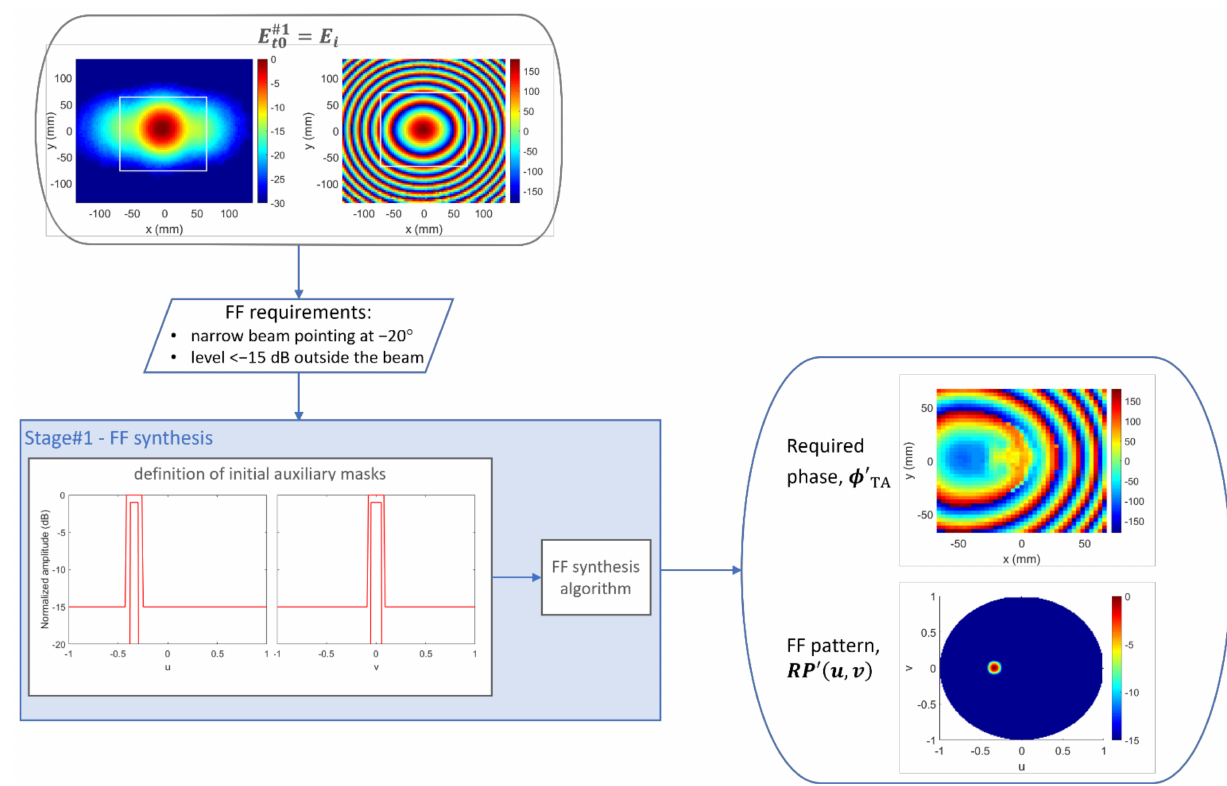
Figure 4. Case 1, Stage#1: inputs and outputs. Field magnitudes are presented normalized in dB, and the phases are presented in degrees.